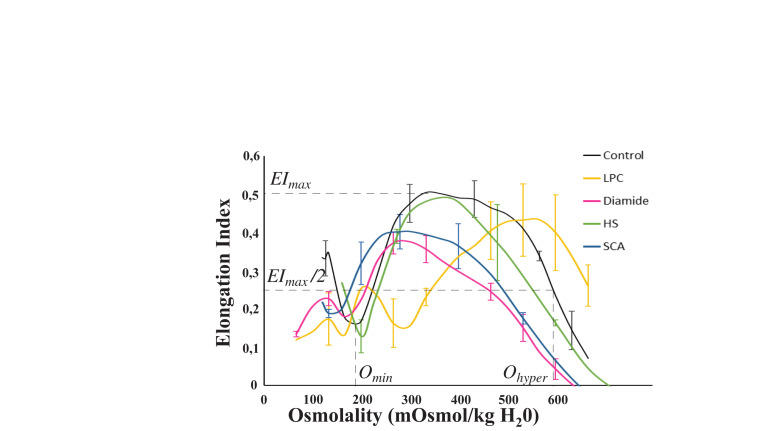
Schematic representation of Osmoscan experiments. Several parameters can be determined on this curve: Omin (i.e., the osmolality at which RBC deformability value reaches a minimum in the hypotonic region of the curve), EImax (i.e., the highest RBC deformability) and Ohyper which corresponds to the osmolality at half of the EImax on the hypertonic region of the curve. LPC treated RBCs at 1.0 μM show an increase in Omin and Ohyper and a decrease in EImax. Diamide treated RBCs at 0.5 mM show a decrease in EImax and Ohyper. These HS patients have a decreased EImax and Ohyper compared to control. Omin, Ohyper and EImax are decreased in these SCA patients compared to control.